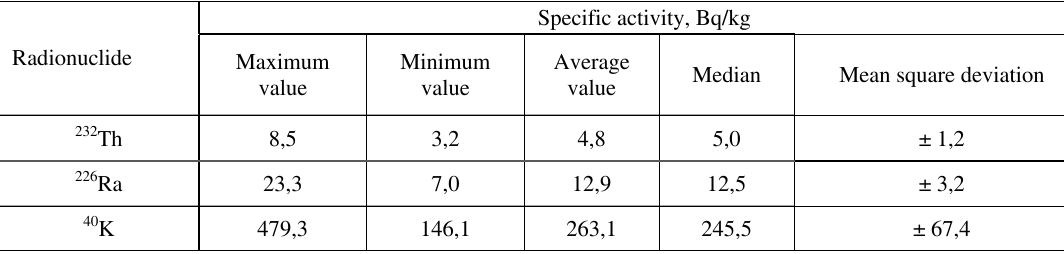
Table 1 . Specific activity of natural radionuclides in the soil of Vilnius city